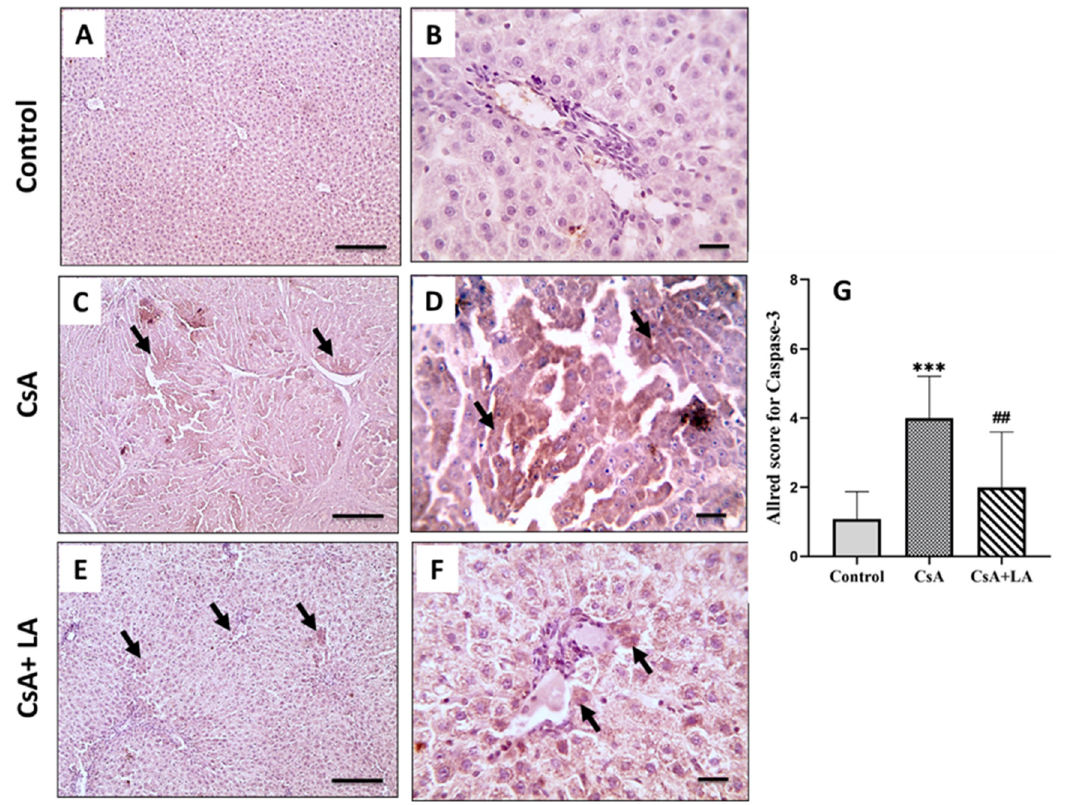
Figure 8. Microscopic pictures of immunostained hepatic sections against caspase-3. The control normal group ( A , B ) shows negative expression. Hepatic sections ( C , D ) from the CsA-treated group show prominent positive brown expression against caspase-3 (black arrows). Hepatic sections ( E , F ) from (CsA + LA) treated group show markedly decreased positive brown expression against